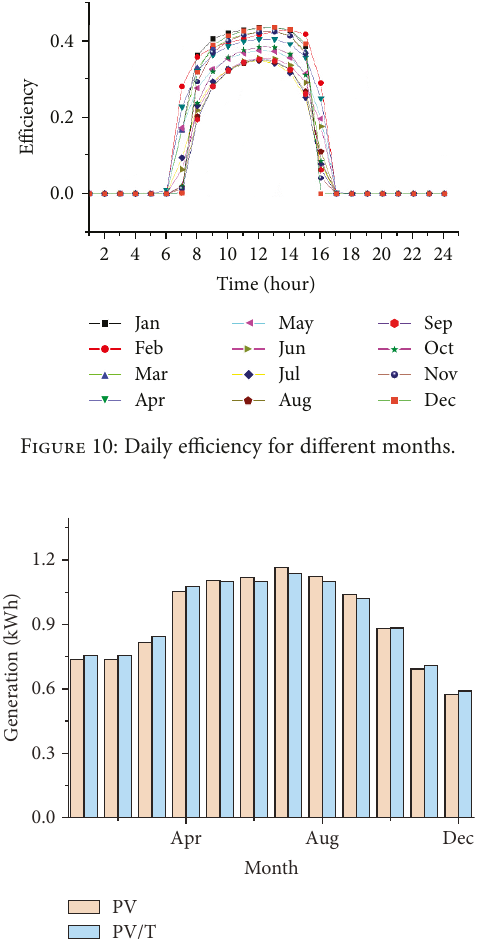
Figure 11: Average daily electricity generation for 1m 2 of PV and PV/T panel for every month. Table 4: Cost, electricity and gas consumption, and CO for the optimal sizing (20 kW of HP, 36 m 2 of PV, and 30m 2 of